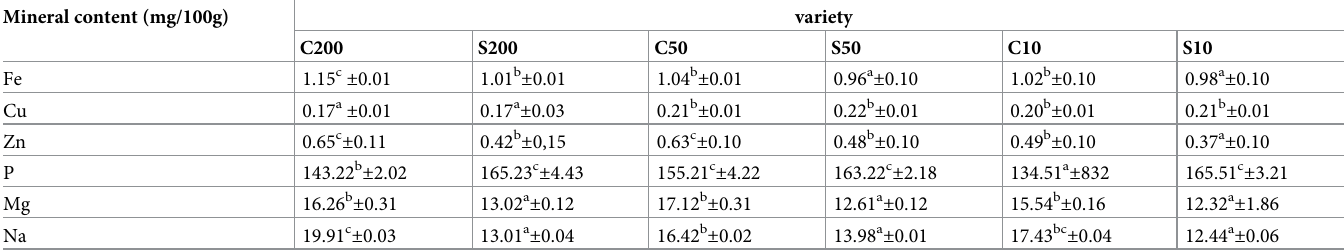
Table 3. Mineral content in extracts from the anatomical parts of the oyster mushroom ( Pleurotus ostreatus L.).